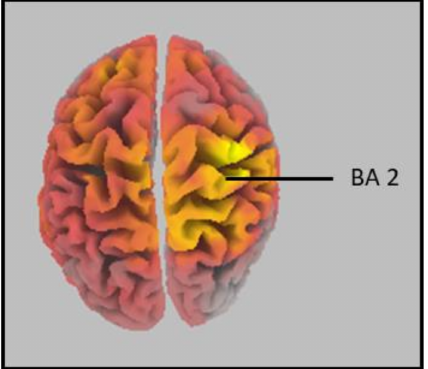
Figure 2. sLORETA 3D Cortex. Area highlighted indicates the region of maximal difference between groups (Control vs. ADHD), which was identified as right-hemispheric BA 2, postcentral gyrus, parietal